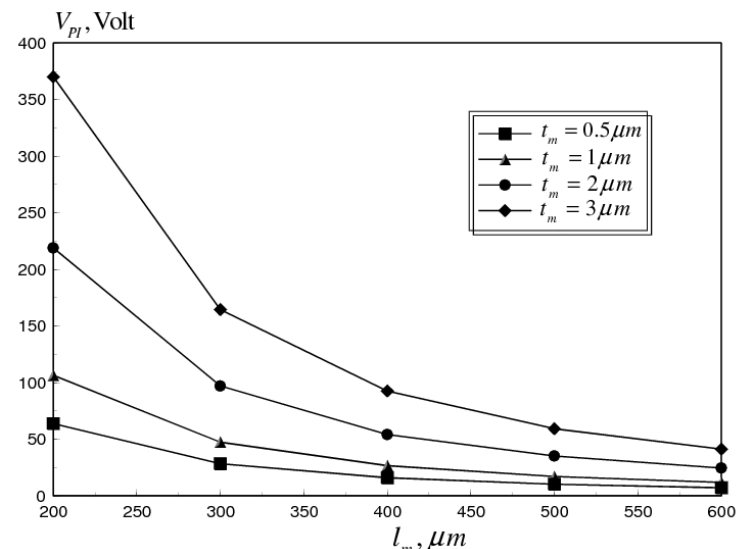
Figure 7. Pull-in-voltage versus membrane length at different membrane thickness of flat